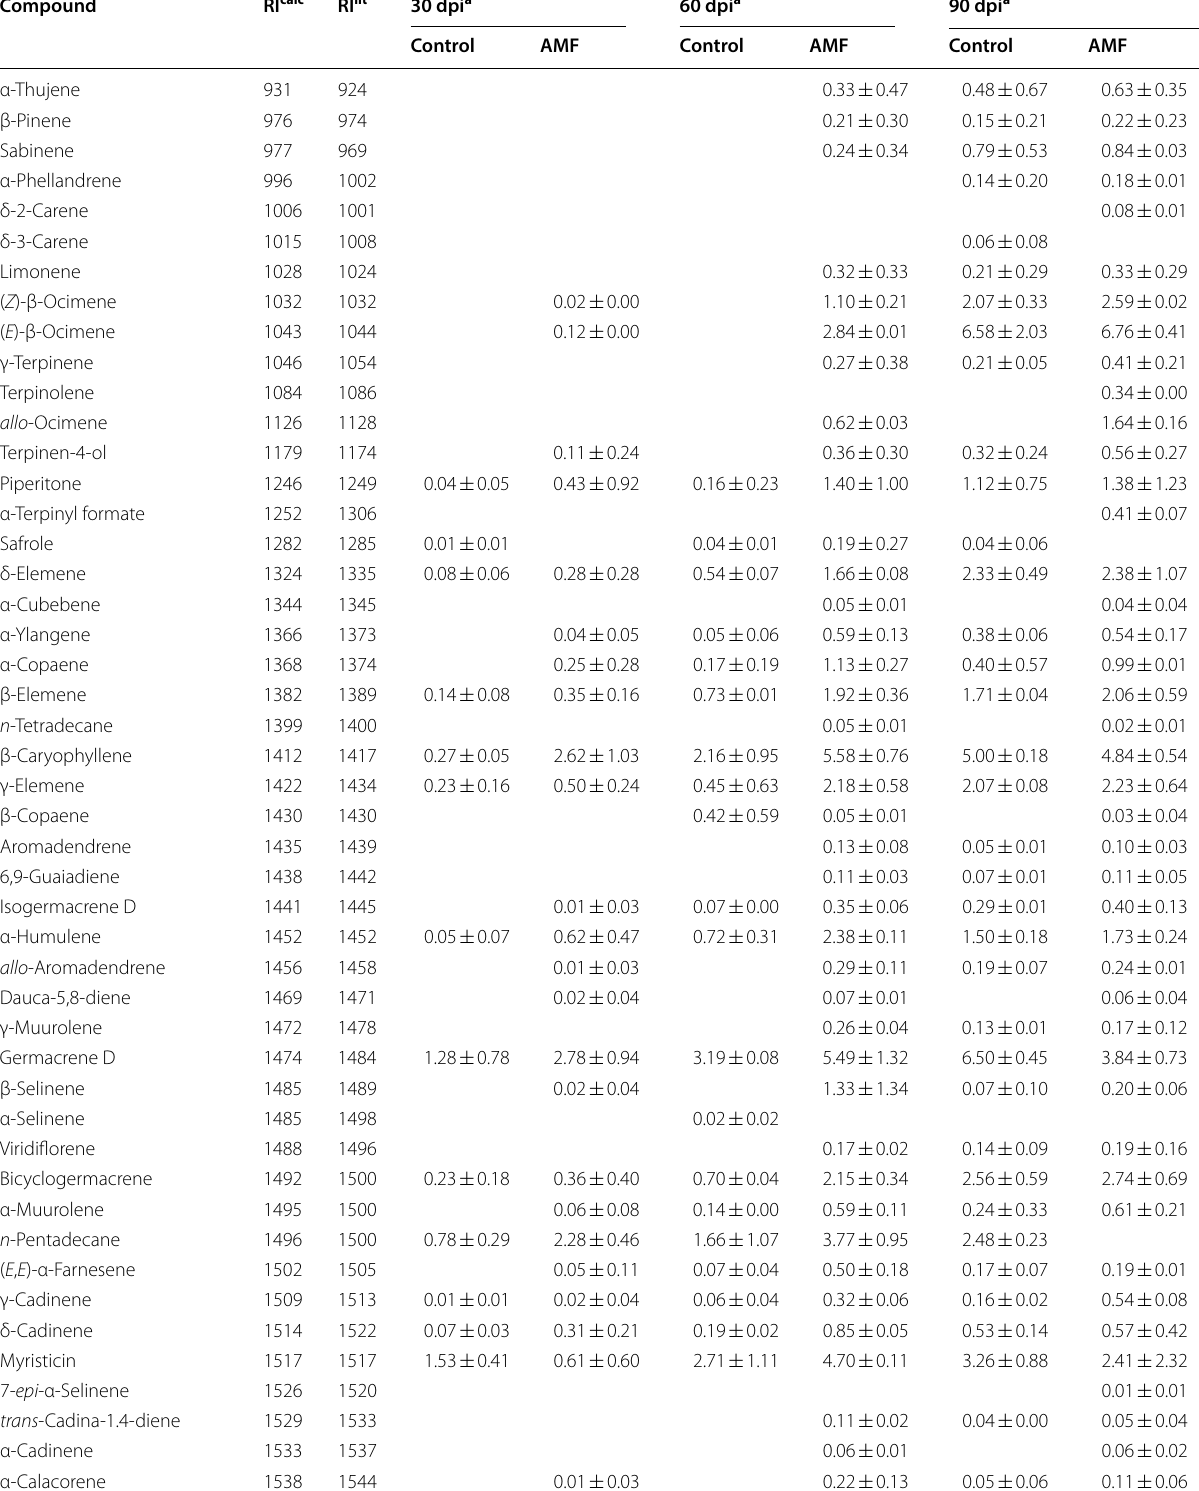
Table 2 Comparison of volatile components produced in inoculated and non-inoculated leaves of P. aduncum (Mean standard